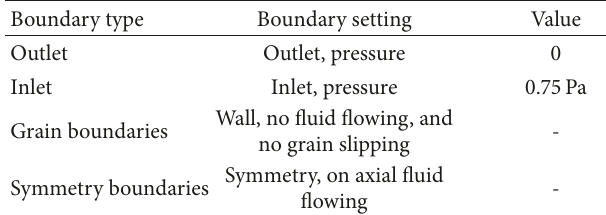
Table 3: Boundary condition settings.